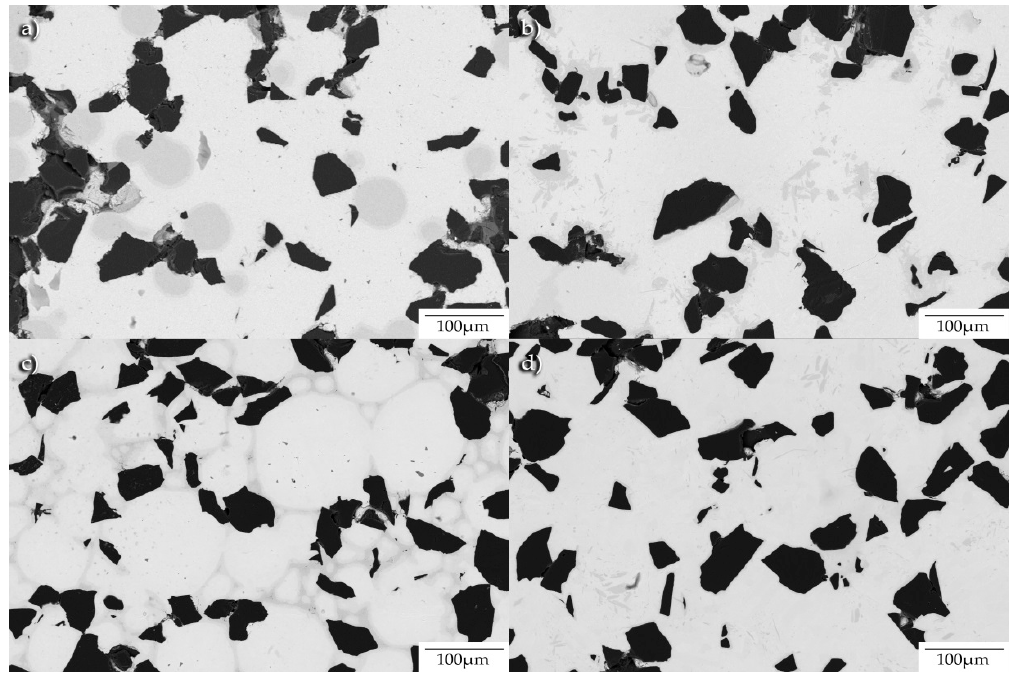
Figure 5. SEM images of the TMCs processed under 80 MPa for 5 min, from the starting materials: ( a ) Ti matrix with TiAl* and B 4 C particles at 1000 °C; ( b ) Ti matrix with TiAl* and B 4 C particles at 1200 °C; ( c ) Ti matrix with Ti-Al and B 4 C particles at 1000 °C; ( d ) Ti matrix with Ti-Al blend and B 4 C particles at 1000 °C.